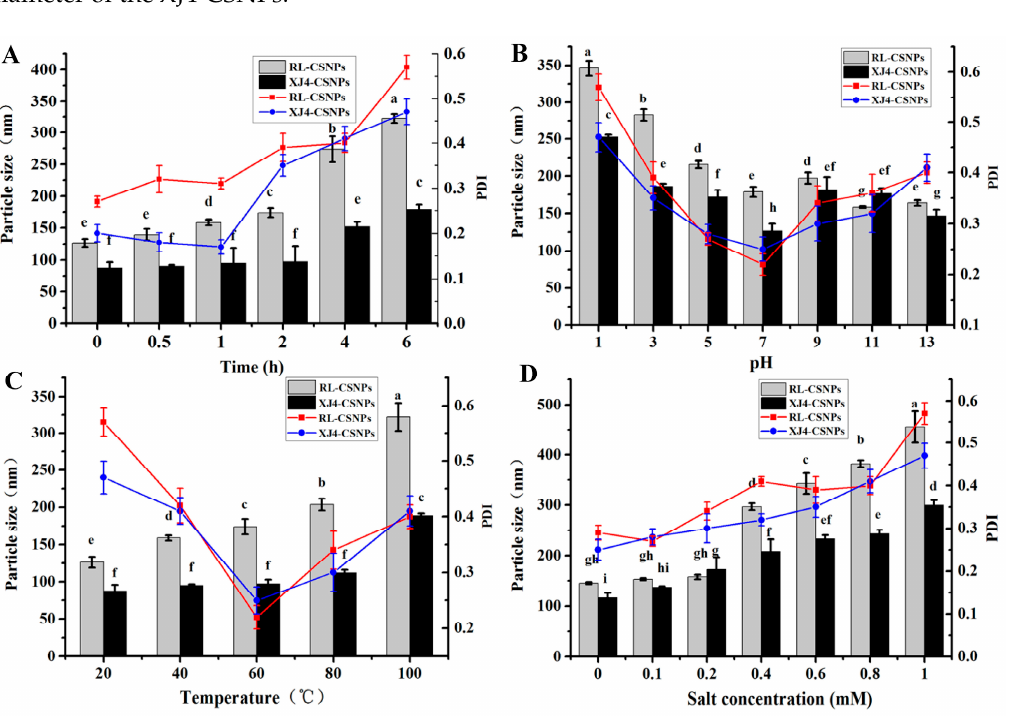
Figure 6. The size and PDI of anthocyanin nanoparticles in di ff erent stress conditions. ( A ) Ultraviolet light exposure time; ( B ) pH; ( C ) temperature; ( D ) salt. The bar chart represents the distribution of particle size and the line chart represents the distribution of PDI. Within samples, di ff erent letters (a–f for Figure 6A, a–h for Figure 6B, a–f for Figure 6C, a–i for Figure 6D) were significantly di ff erent ( p < 0.05).